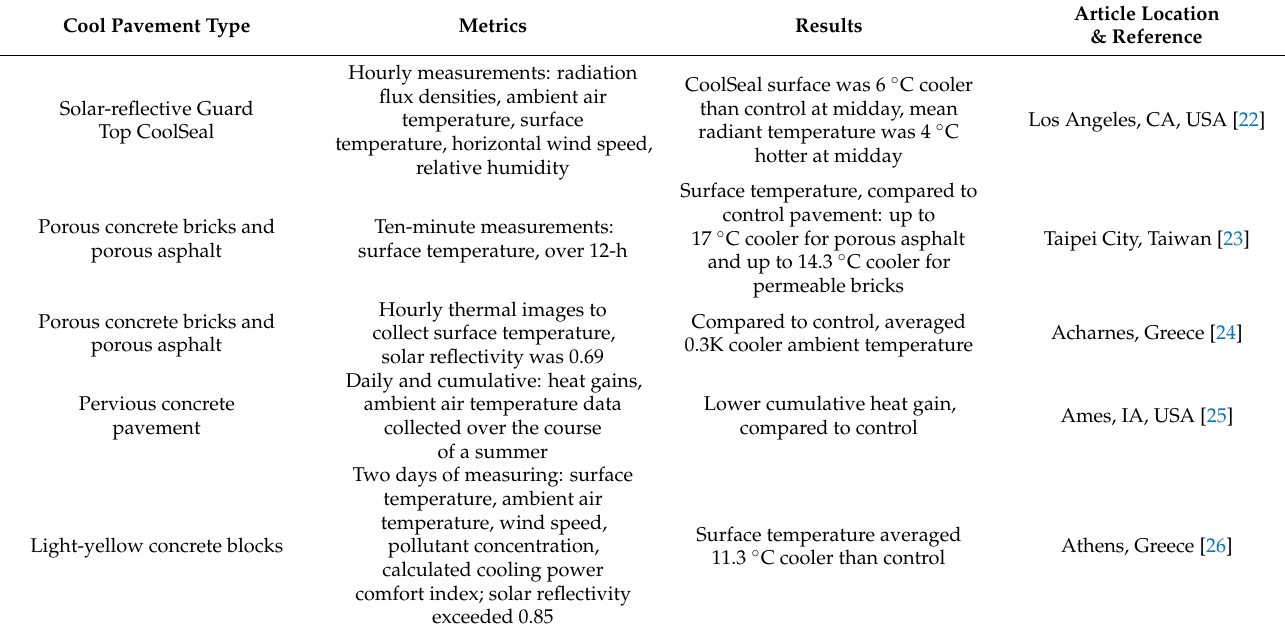
Table 1. Summary of evaluation metrics and results from cool pavement intervention studies.